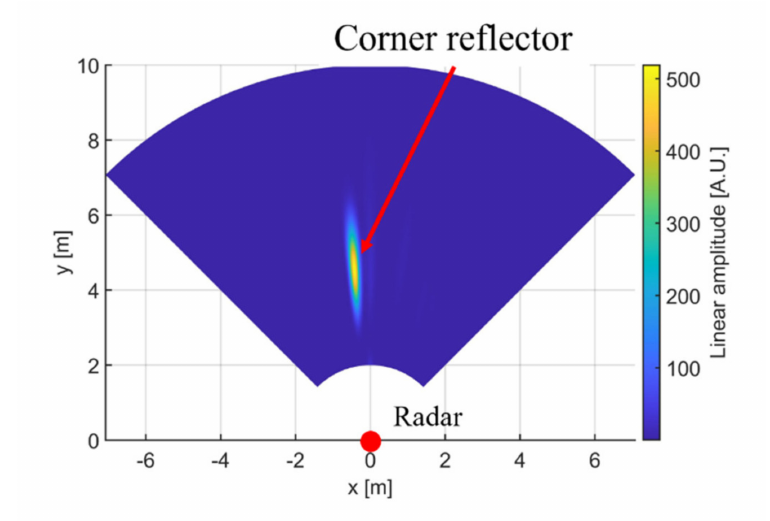
Figure 9. Radar image focused on the horizontal plane at z = − 2.8